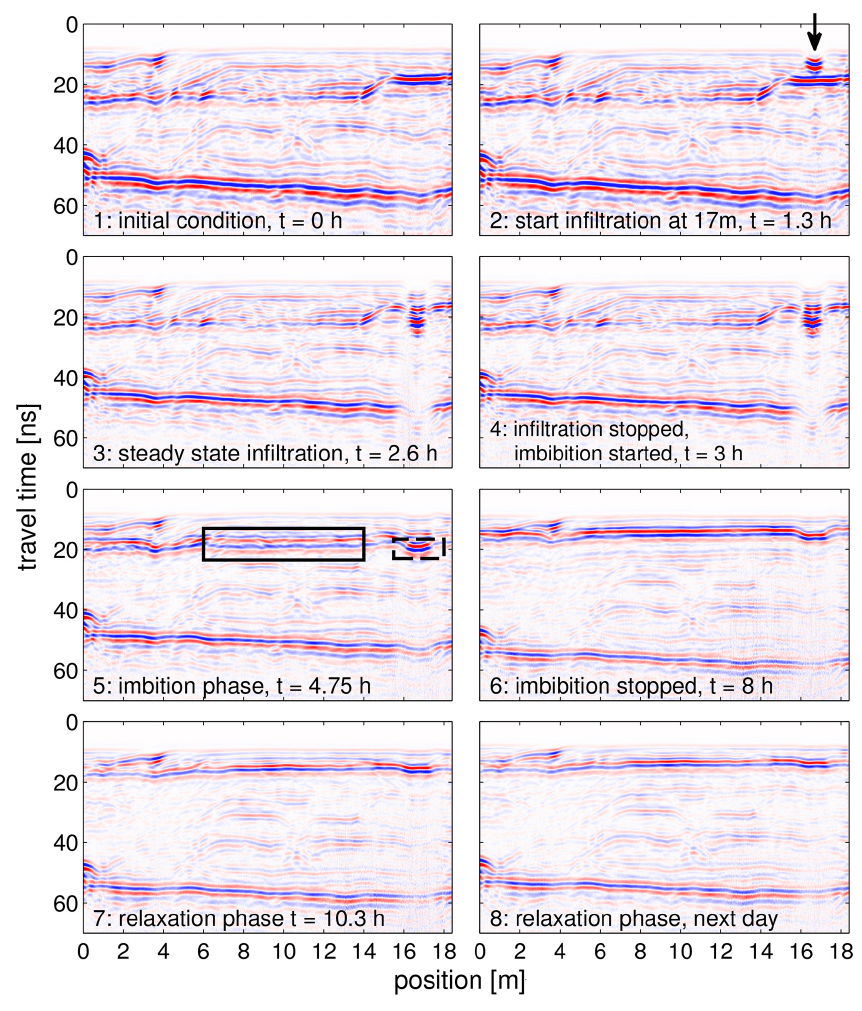
Figure 10. Common offset radargrams showing the hydraulic state of experiment 2 at several characteristic times: localized infiltration at 17m (denoted by the black arrow in radargram 2) followed by imbibition and a period of relaxation. The dashed (solid) black rectangle in radargram 5 highlights the CFR in a (non) pre-wetted position during the imbibition phase.